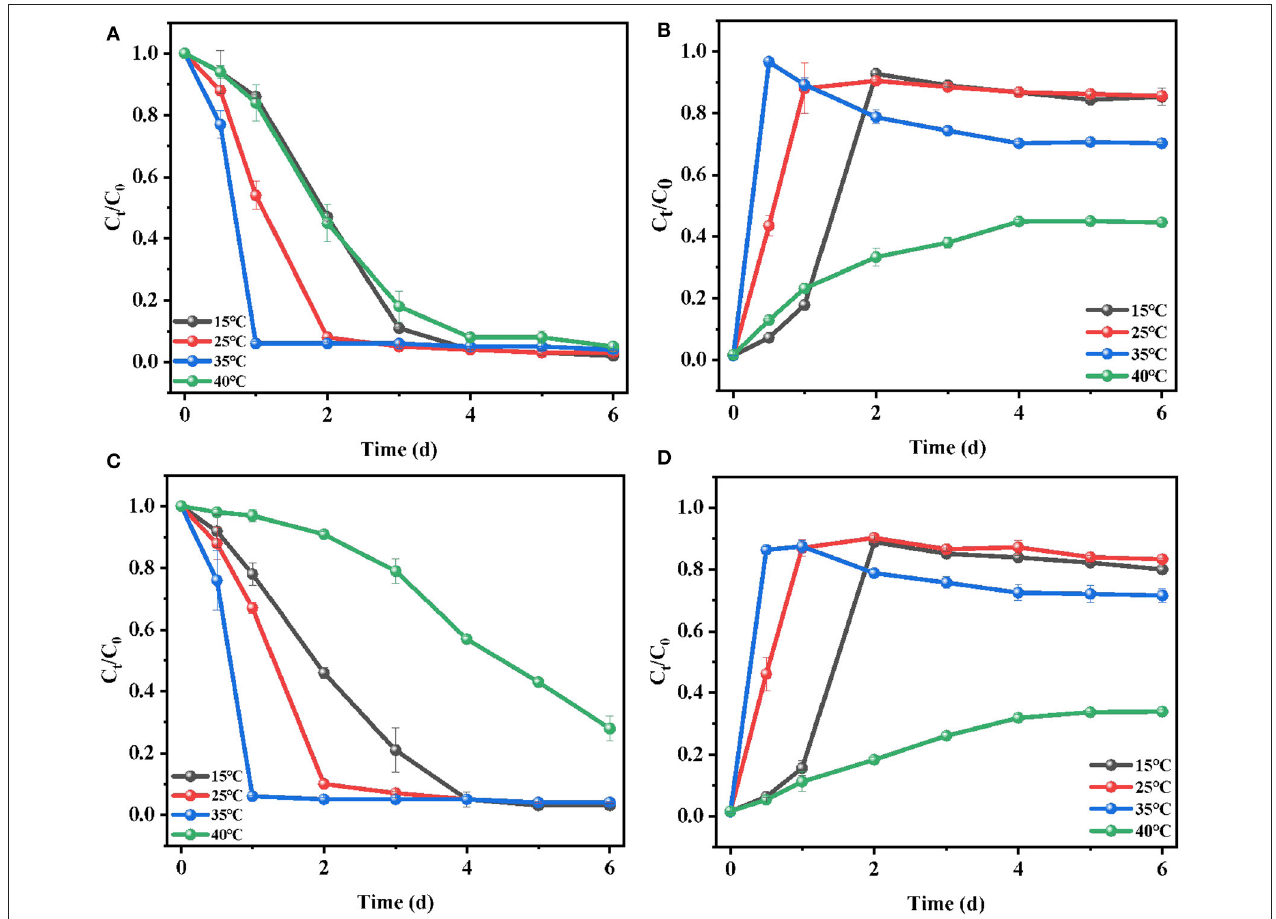
FIGURE 4 | Effects of temperature on the biodegradation of E2: (A) degradation efficiency of E2 by C. utilis CU-2; (B) cell growth of C. utilis CU-2, measured with OD at λ = 600nm; (C) degradation efficiency of E2 by L. casei LC-1; (D) cell growth of L. casei LC-1, measured with OD at λ = 600nm. The concentration of sucrose addition was at 0.6 g/L, ([E2] 0 = 10 µ M, the initial pH = 7.0 ± 0.2).